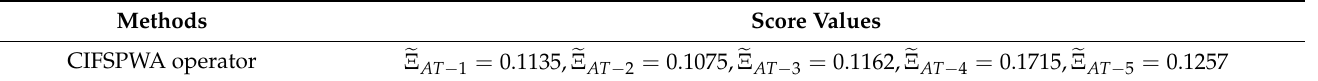
Table 6. By using the information in step 2, we obtain the score values.